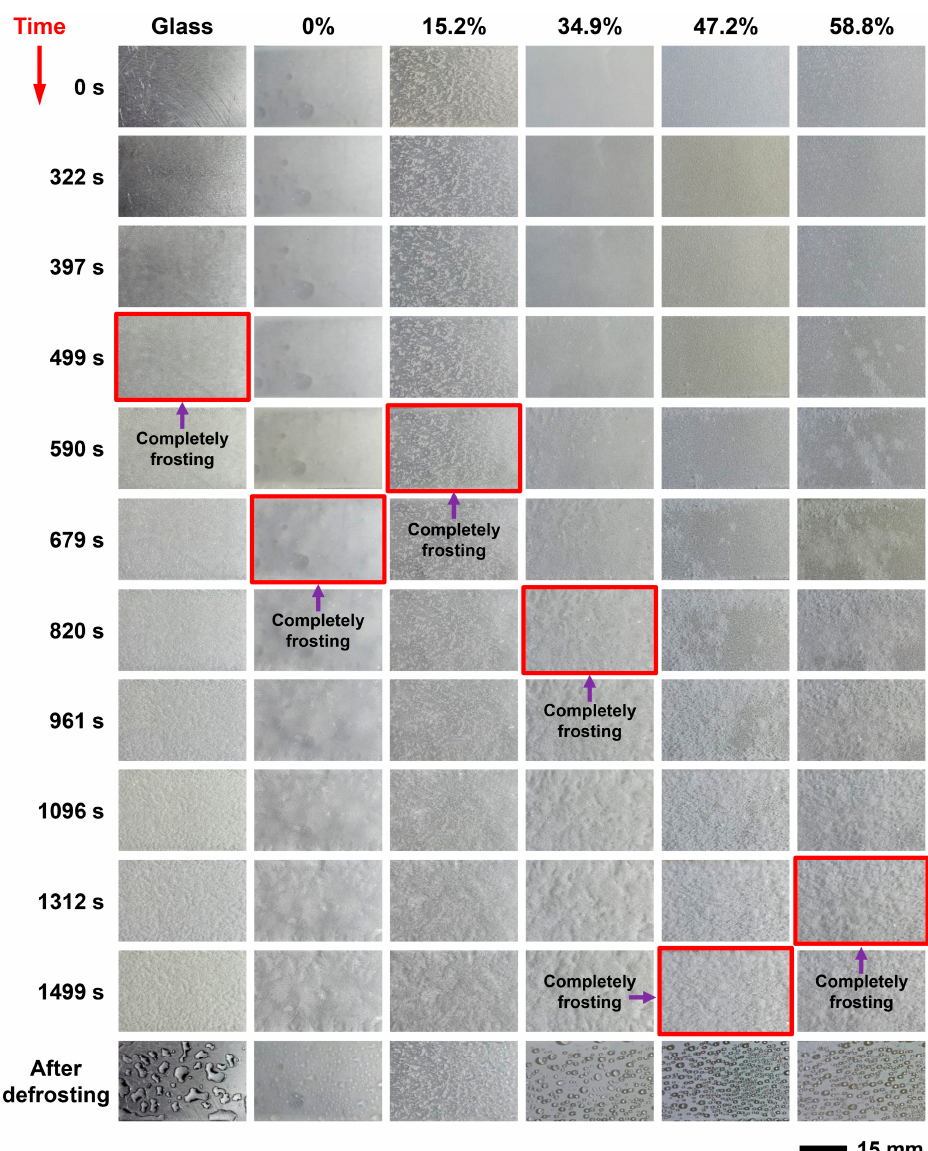
Figure 5. Anti-frosting performance of glass and coatings with different mass fractions.